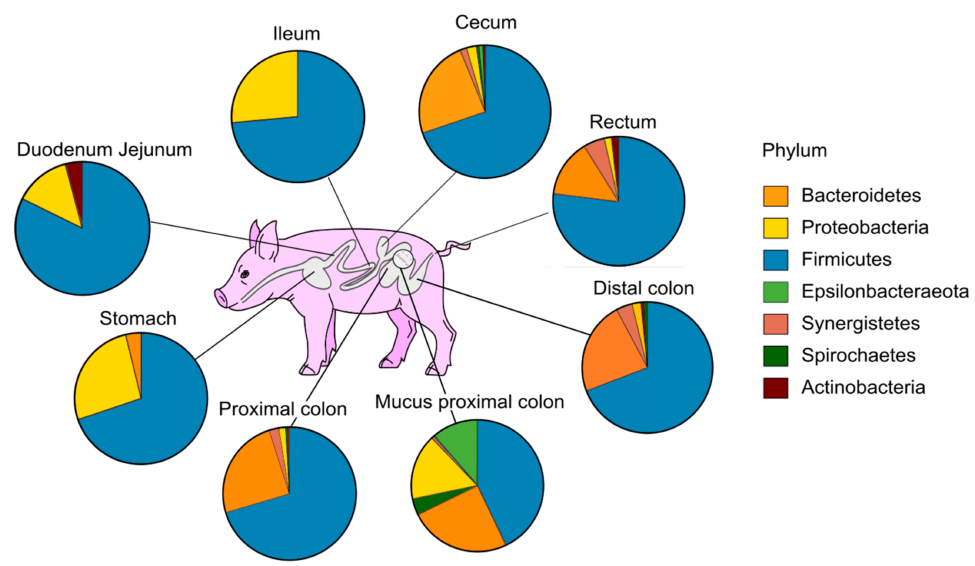
Figure 2. Mean relative abundance of the phylum-level microbiota across the weaning piglet